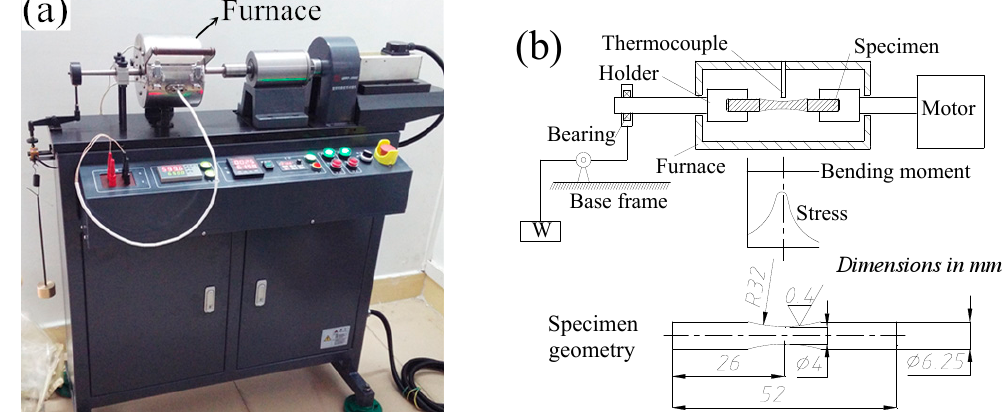
Figure 10. ( a ) Rotating bending fatigue tester; ( b ) schematic diagram of fatigue test and specimen geometry.